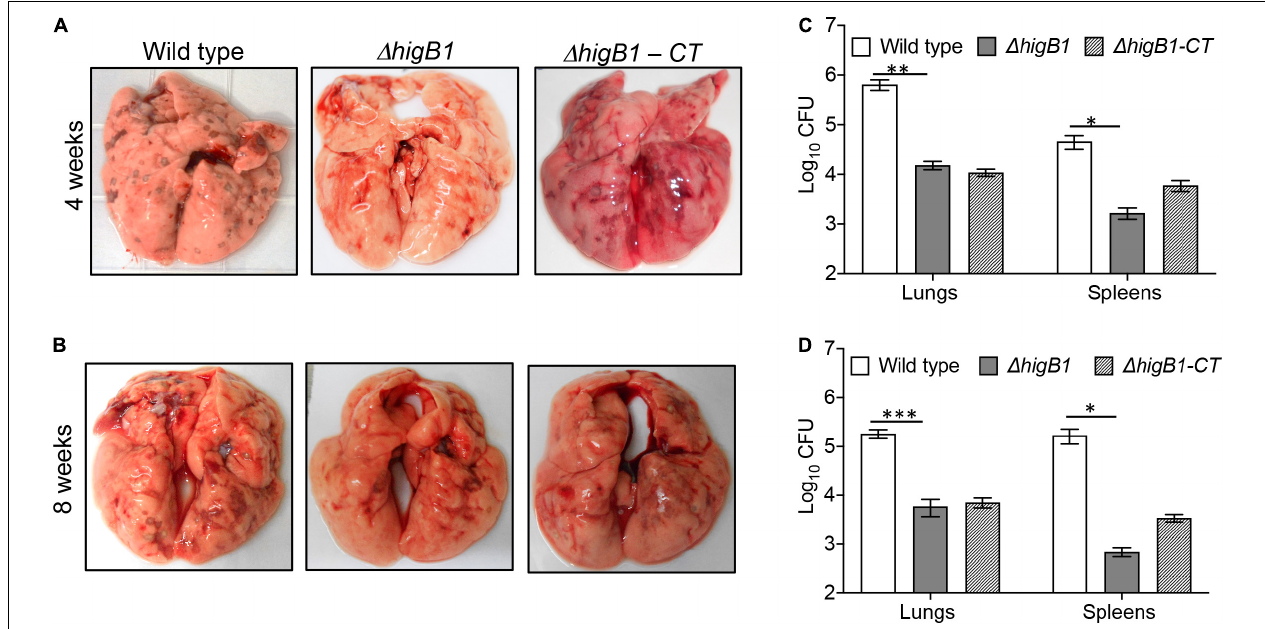
FIGURE 5 | HigB1 locus is important for M. tuberculosis pathogenesis in guinea pigs. (A,B) This panel depicts representative lung images from guinea pigs infected with either wild type or (cid:49) higB 1 mutant or higB 1 complemented strains at 4 weeks (A) and 8 weeks (B) post-infection. (C,D) This panel depicts the lungs and splenic bacillary loads in guinea pigs infected with various strains at 4 weeks (C) and 8 weeks (D) post-infection. The data shown in this panel is mean ± SE of Log 10 CFU obtained from 6 or 7 animals per group per time point. Statistically significant differences were observed for the indicated groups, ∗ P < 0.05, ∗∗ P < 0.01, and ∗∗∗ P < 0.001.